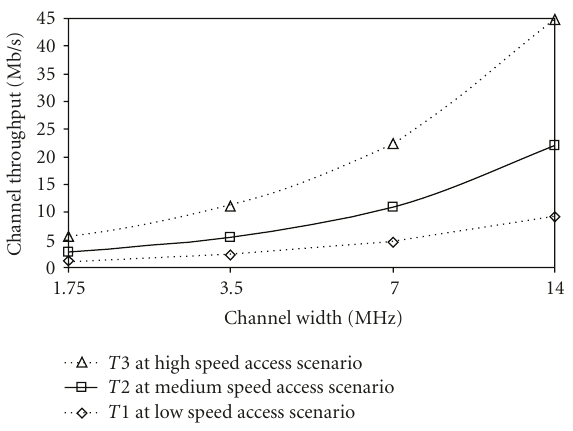
Figure 3: Channel throughput and channel size for each access